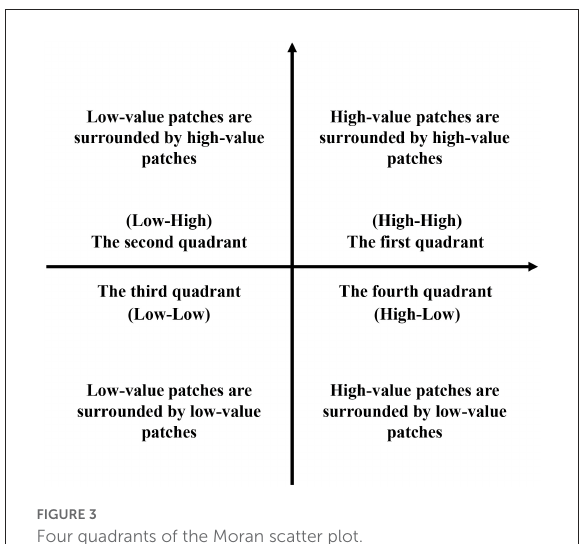
FIGURE3 Four quadrants of the Moran scatter